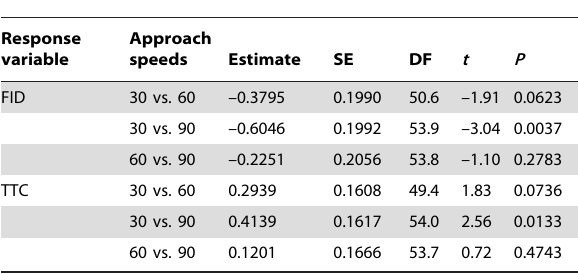
Table 4. Differences in least squares means associated with a mixed linear model, repeated-measures analysis of flight- initiation distance (FID) and time-to-collision (TTC) for groups of free-ranging turkey vultures exposed to the approach of a Ford F250 pickup truck from a standard 1.13-km distance at 30 kph (n=25 approaches), 60 kph (n=25 approaches, but only 24 considered because of a missing value), or 90 kph (n=23